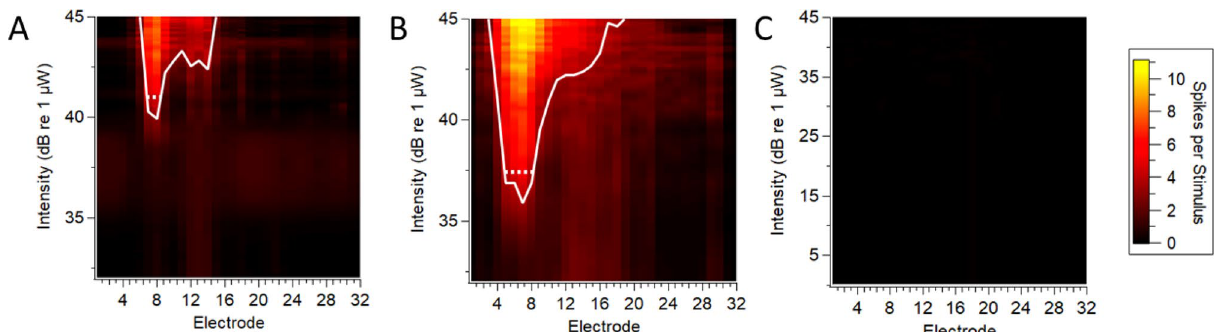
Figure 6. ( A ) Spatial response image recorded from 5 ms optical pulses from a RWM-positioned optical fibre in an AAV-injected C57BL/6 mouse with 55% ChR2-H134R-EYFP transduced cells in the apical turn but no basal turn expression (expression pattern shown in Fig. 3). The dorsal best electrode in this response image is suggestive of activation of apical turn neurons ( B ) Response image from the same mouse generated from an apically-positioned optical fibre (5 ms pulse). ( C ) No multiunit inferior colliculus activity was recorded in a mouse that had no detectable expression of ChR2-H134R-EYFP in any cochlear turn (image from 10 ms optical pulse). Response images were generated as per Fig. 4. The dotted lines compare the width of activation at an equivalent level above threshold (d’ = 1 above